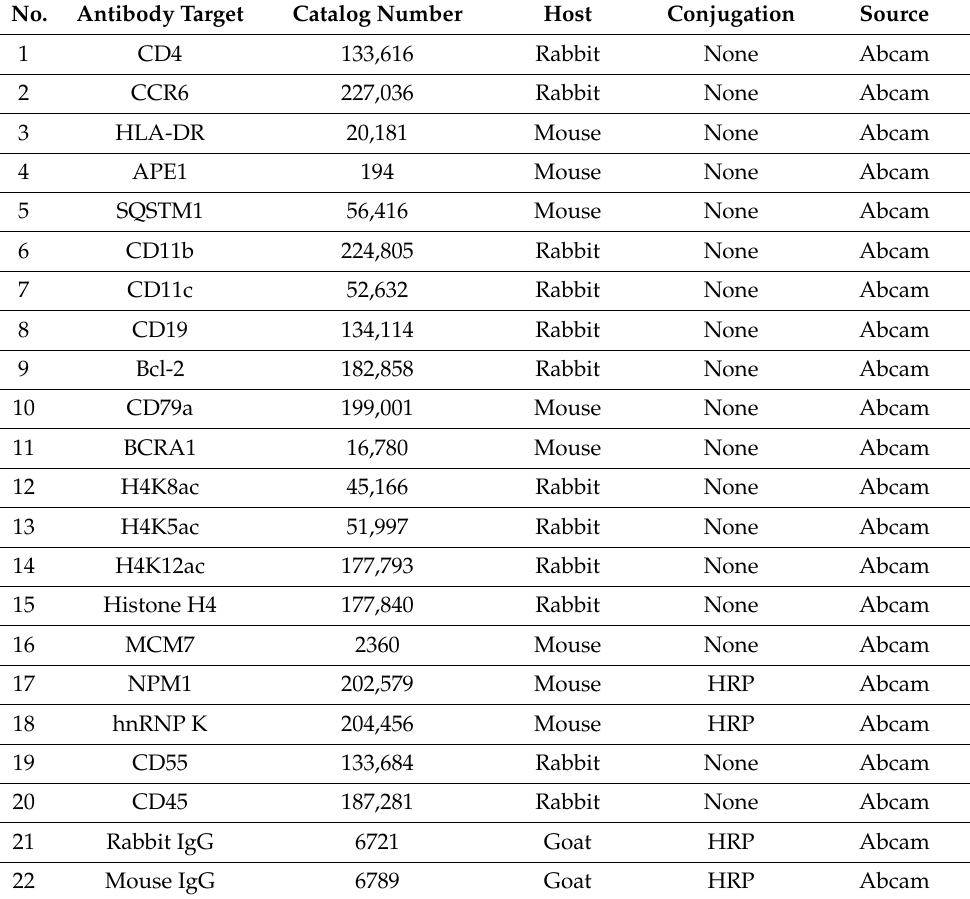
Table 1. The antibodies used in this